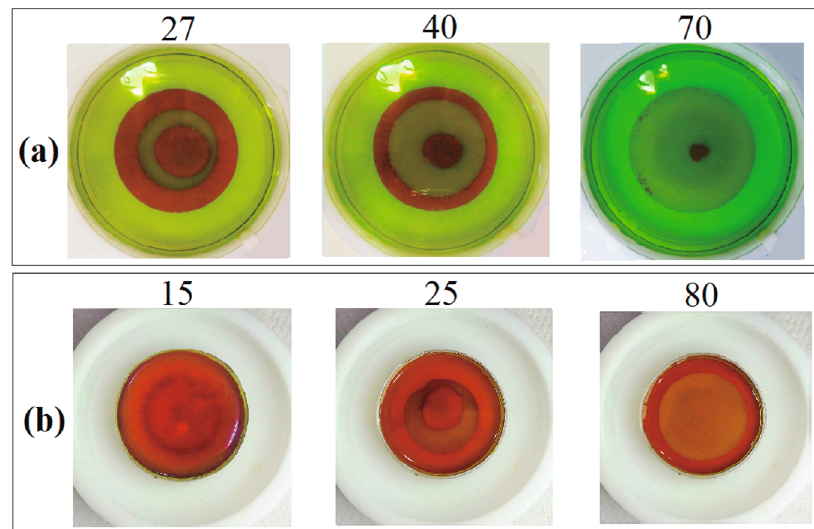
Fig. 5 Corrosion of CCL disc using a magnet smaller than CCL disc. a Pictures of the corrosion process on the CCL disc in the SMBC setup (Fig. 8b-III). b Pictures of the corrosion process on the CCL disc in the SMSC setup (Fig.